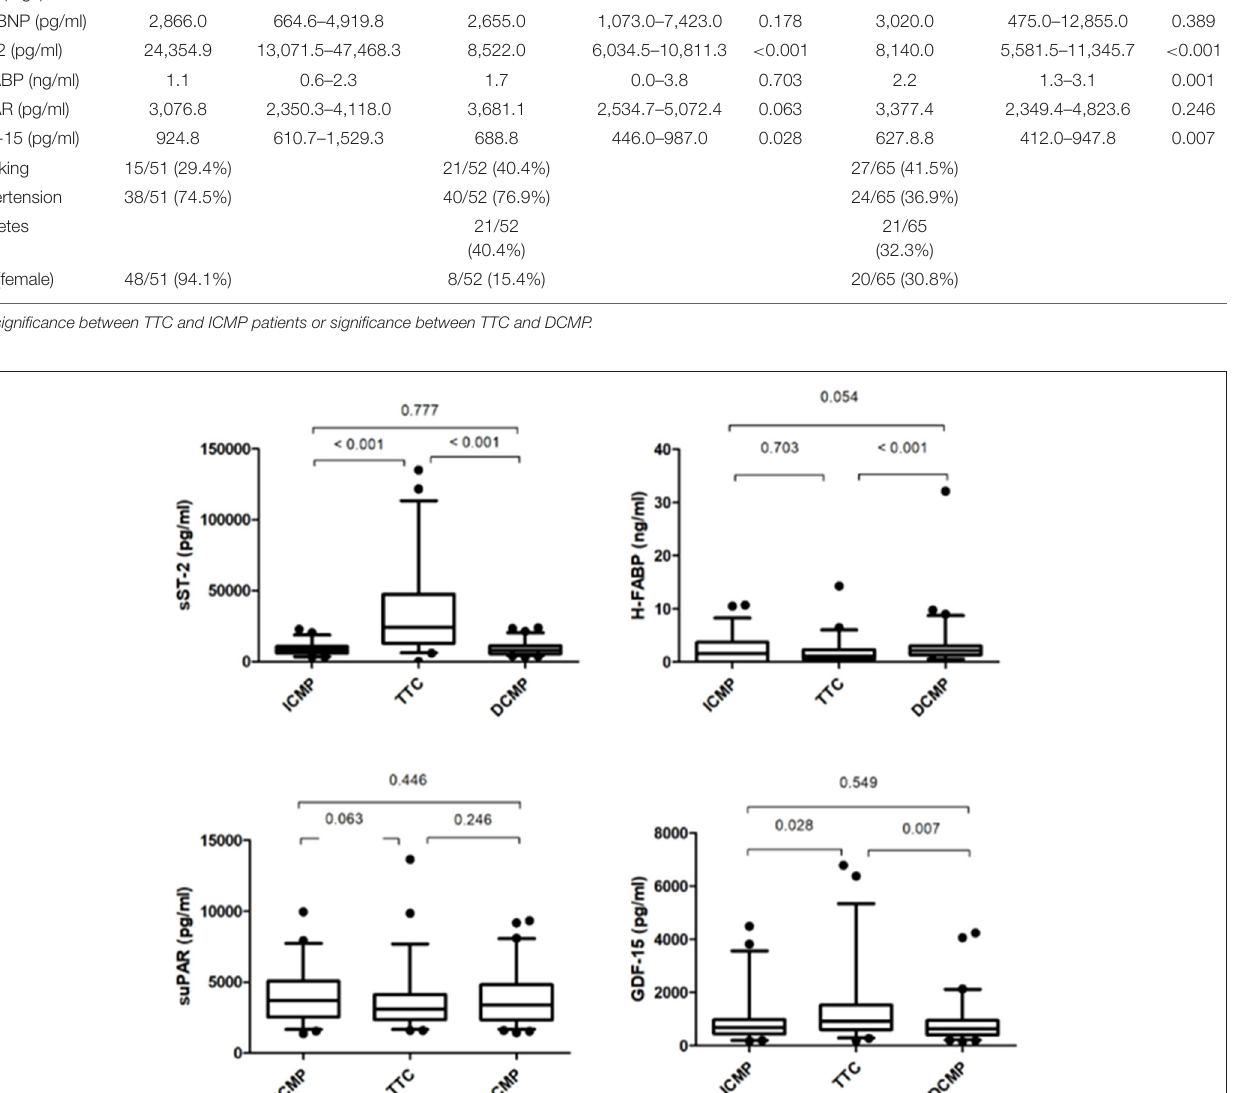
C-reactive protein (CRP) or LDL-cholesterol were found. A strong correlation was found between sST-2, suPAR, GDF-15 and